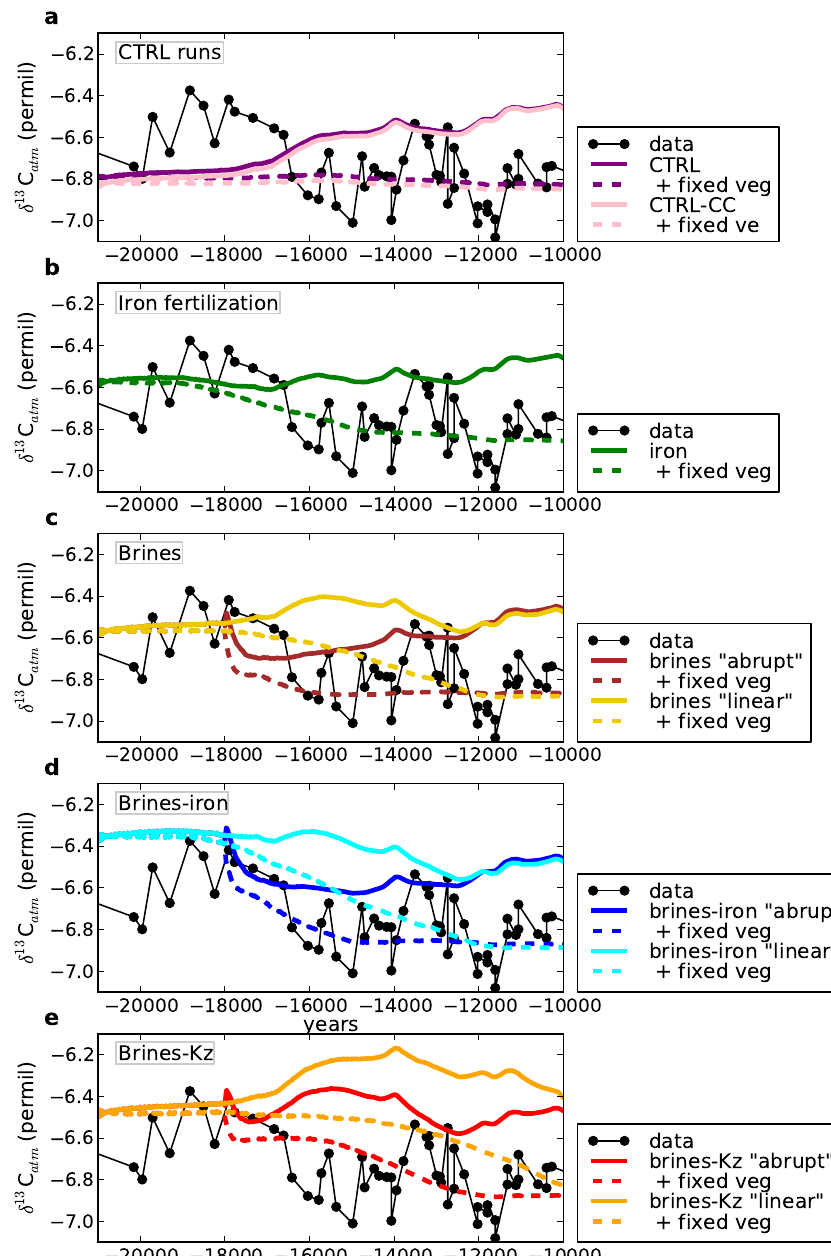
Fig. 11. Evolution of atmospheric δ 13 C atm during the last deglaciation with different oceanic mechanisms and comparison with data: (a) con- trol (CTRL) runs without and with carbonate compensation (CC), all other simulations are with carbonate compensation, (b) simulations with iron fertilization, (c) simulations with the sinking of brines (two scenarios as defined in Fig. 6), (d) simulations with the sinking of brines (two scenarios as defined in Fig. 6) and iron fertilization, (e) simulations with the sinking of brines (two scenarios as defined in Fig. 6) and interactive vertical diffusion coefficient ( K z ). Each simulation has either an interactive vegetation or a fixed glacial vegetation (“fixed veg”). The data are from Lourantou et al.